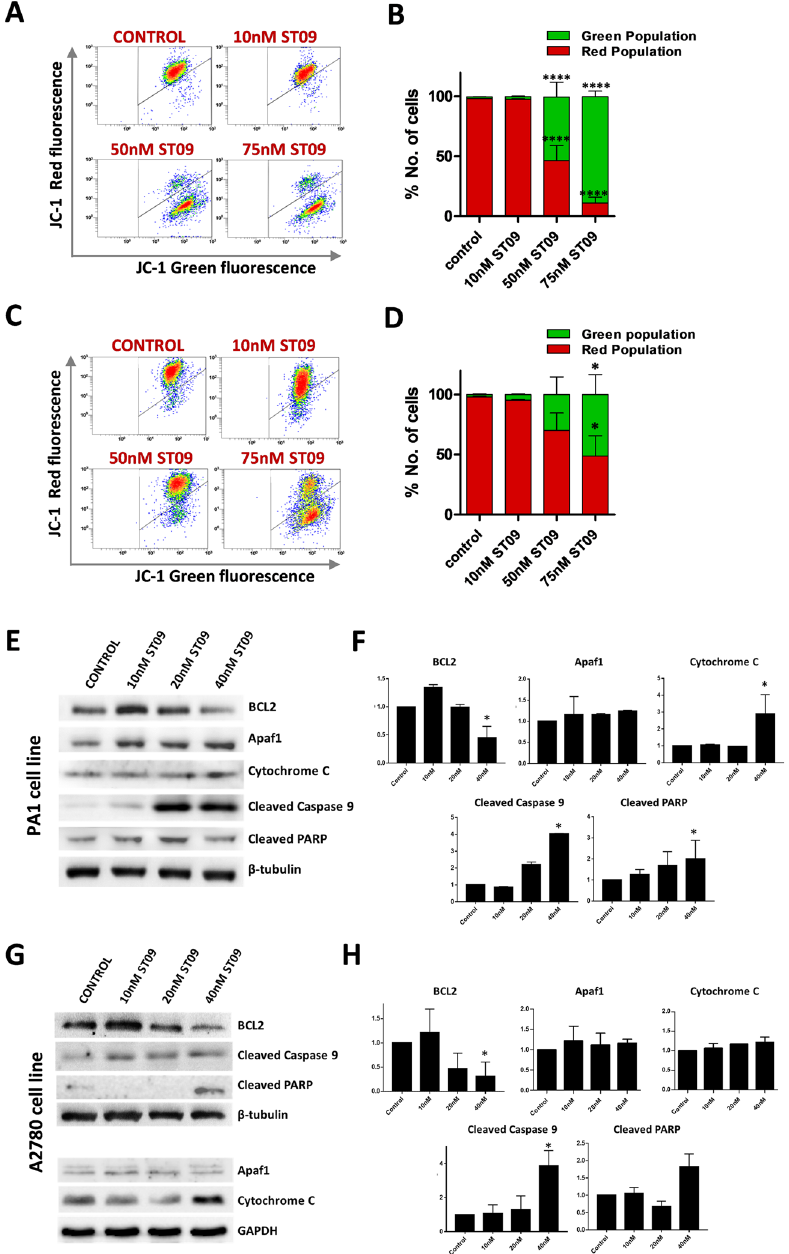
Figure 2. Altered mitochondrial membrane potential and expression of mitochondrial-mediated apoptotic proteins in ST09 treated ovarian cancer cell lines. ( A ) Dot plot and ( B ) Quantification of JC1 staining of PA1 cells treated for 48 h with increasing concentrations of ST09 analysed by flow cytometry. ( C) Dot plot and ( D) Quantification of JC1 staining of PA1 cells treated for 48 h with increasing concentrations of ST09 analysed by flow cytometry. Flow cytometry quantification percentage of cells with green JC-1 monomers (apoptotic cells) and red JC1 aggregates (healthy cells). The median fluorescence intensity (MFI) was plotted as means ± SD from three independent experiments. Flow cytometry dot plots are generated using Gallios software (version 1.2, https:// www. mybec kman. in/ flow- cytom etry/ softw are/ kaluza- for- galli os). ( E) Apoptotic protein expression and ( F) Quantification of PA1 cells treated with increasing concentrations of ST09 for 48 h. ( G) Apoptotic protein expression and ( H) Quantification of A2780 cells treated with increasing concentrations of ST09 for 48 h. Uncropped gel images are provided in the supplementary information. Significance plotted based on p values, and represented as *( p -value < 0.05), and ****( p -value <